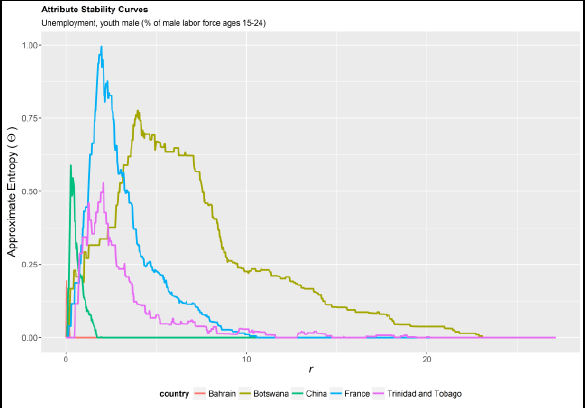
Figure 4. Attribute Stability Curves of Examples